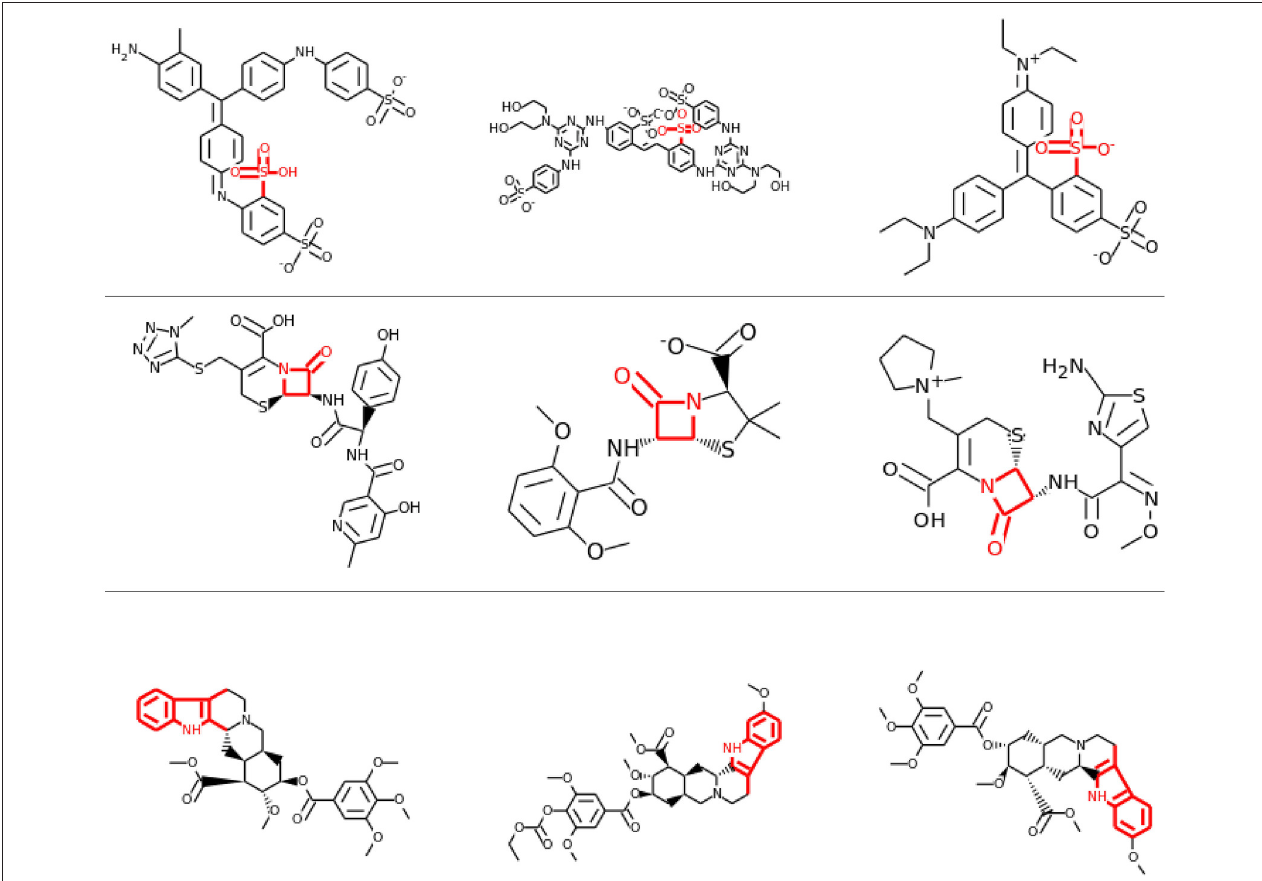
FIGURE 8 | Feature Construction by Deep Learning. Neurons that have learned to detect the presence of toxicophores. Each row shows a particular hidden unit in a learned network that correlates highly with a particular known toxicophore feature. The row shows the three chemical compounds that had the highest activation for that neuron. Indicated in red is the toxicophore structure from the literature that the neuron correlates with. The first row and the second row are from the first hidden layer, the third row is from a higher-level layer.